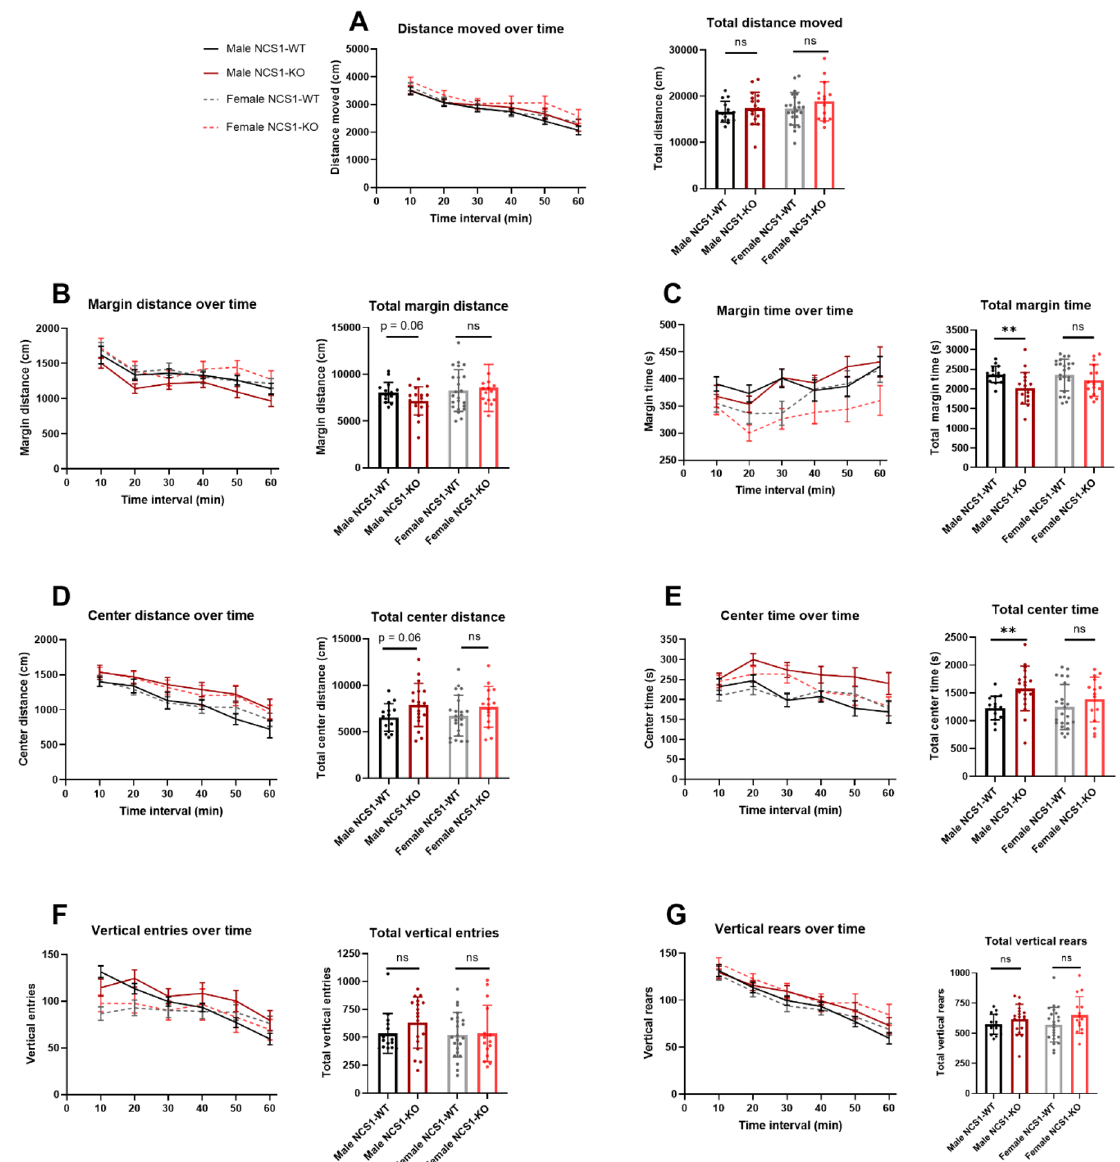
Figure 5. Male NCS1-KO mice exhibit hyperactivity in the open-field exploration task. Graphs show ( A ) distance moved (no differences), ( B ) margin distance (unpaired t-test, p = 0.06 for male NCS1-WT vs. male NCS1-KO, ( C ) margin time (unpaired t-test, p = 0.005 for male NCS1-WT vs. male NCS1-KO), ( D ) center distance (unpaired t-test, p = 0.06 for male NCS1-WT vs. male NCS1-KO), ( E ) center time (unpaired t-test, p = 0.005 for male NCS1-WT vs. male NCS1-KO); ( F ) vertical entries (no differences), and (G) vertical rears (no differences). Line graphs show mean ± SEM. Bar graphs show mean ± SD. Two-tailed student t-test was used to compare male NCS1-WT with male NCS1-KO, and female NCS1-WT with female NCS1-KO. Male NCS1-WT: n = 15, male NCS1-KO: n = 18, female NCS1-WT: n = 15, female NCS1-KO: n =